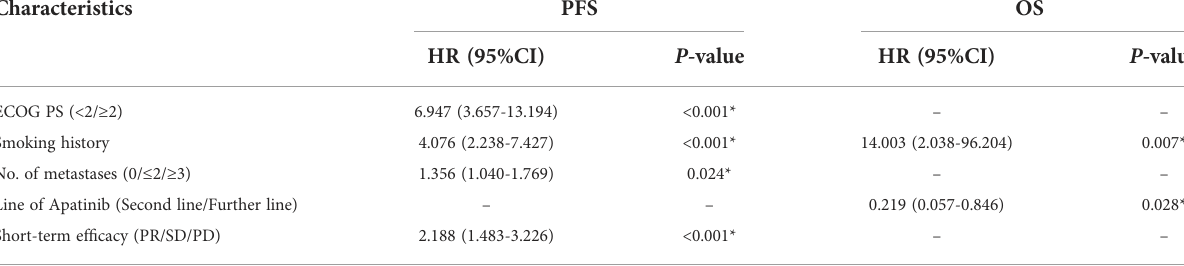
TABLE 3 Multivariate analysis of PFS and OS in patients with